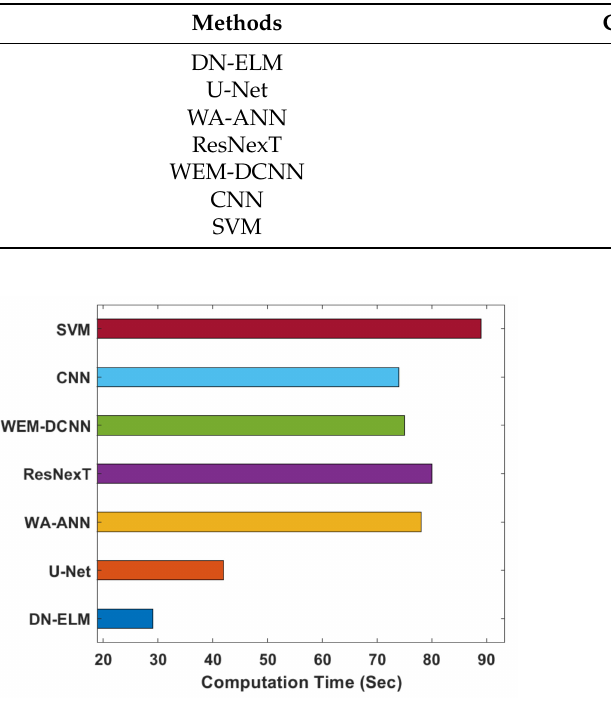
Figure 8. Computation time analysis of the DN-ELM